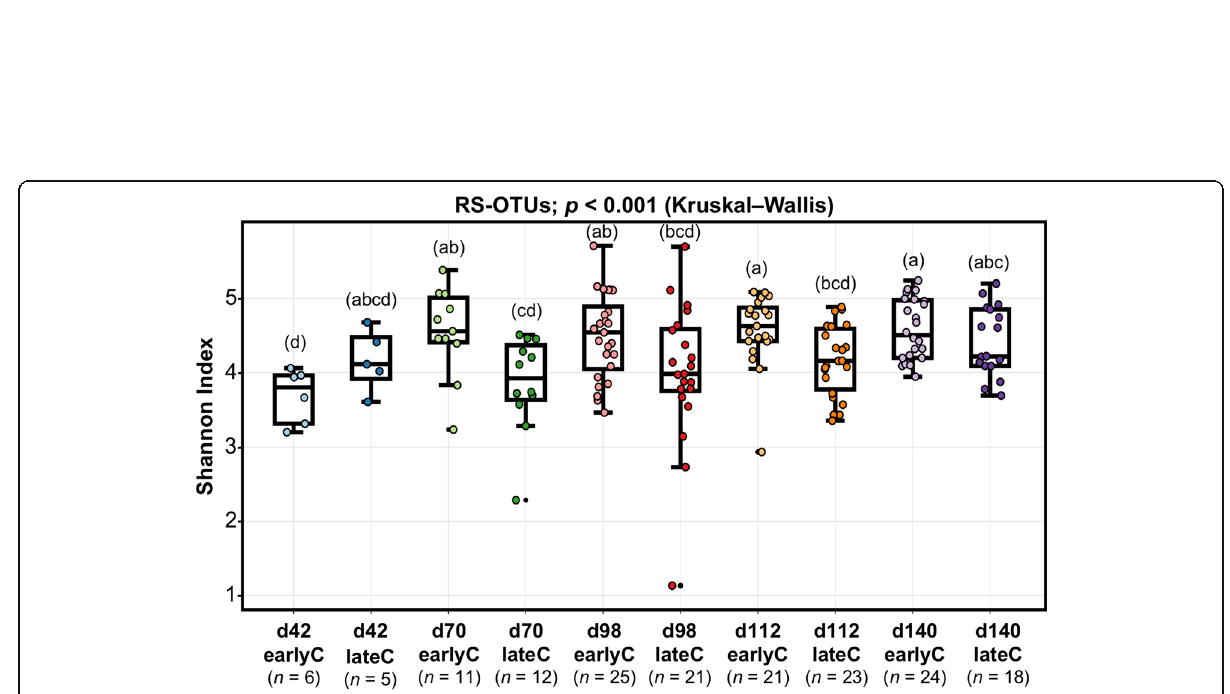
Fig. 4 Shannon index of RS bacterial communities in BS samples of different weaning groups of calves. Different weaning periods within each age group are shown by different